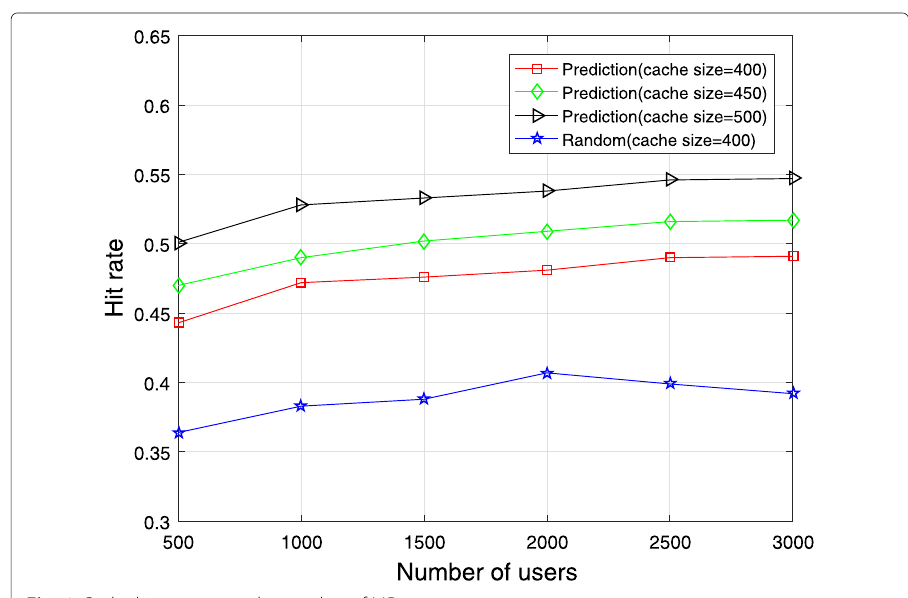
Fig. 6 Cache hit rate versus the number of MDs